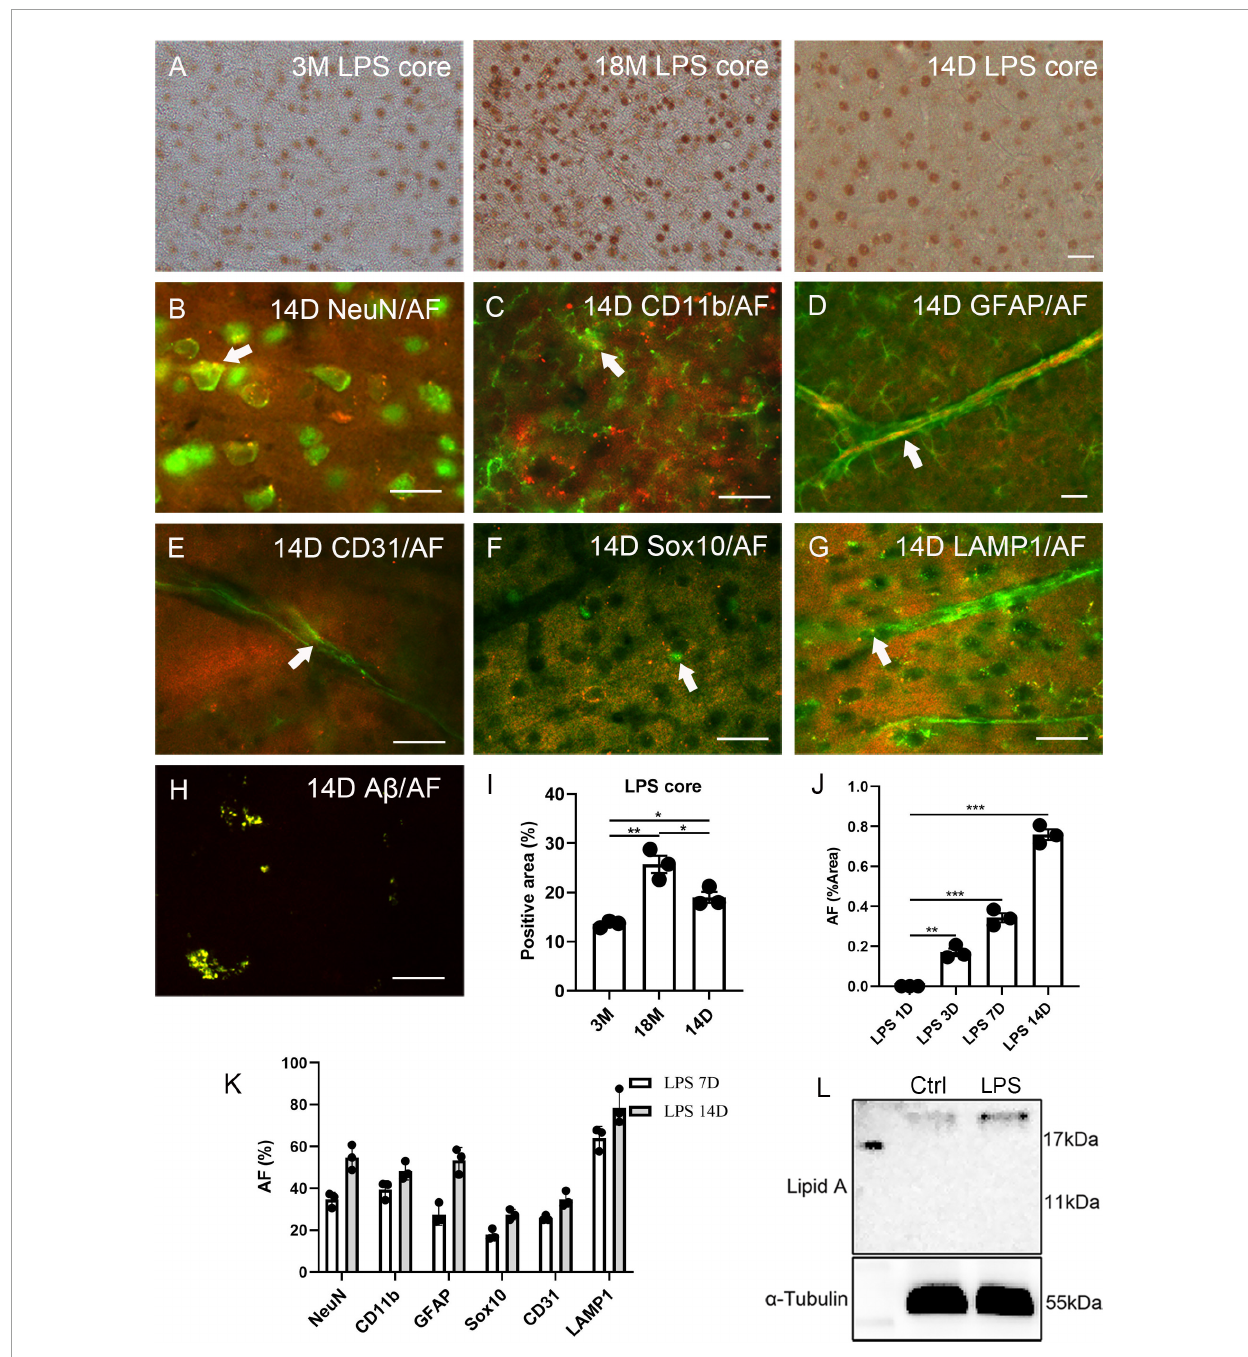
FIGURE3 Correlation between lipopolysaccharide (LPS) and AF within mouse brains. The representative images of LPS core staining of mouse brains at 3 months (3M) and 18 months (18M) of age and 14 days (14D) after LPS injection (A) . LPS-induced AF (rhodamine channel) co-localized with NeuN (B) , CD11b (C) , GFAP (D) , CD31 (E) , Sox10 (F) , and LAMP1 (G) . LPS-induced A β co-localized with AF (rhodamine channel) (H) . The positive area percentage of LPS core at 3 months (3M), 18 months (18M) of age, and 14 days after LPS injection (I) . The area percentage of AF in 1 day (1D), 3 days (3D), 7 days (7D), and 14 days (14D) LPS-injected mouse brain sections (J) . The percentage of AF-positive cells 7 days (7D) and 14 days (14D) mice after LPS injection (K) . Western blot of lipid A of the cortex of 6 weeks old mice after LPS injection for 1 day and age-matched control (L) . The arrows indicate fluorescence coincident with AF. The scale bars represent 20 µ m. The data are presented as the mean ± SE. Significance analysis with one-way analyses of variance (ANOVA) followed by Tukey’s multiple comparisons test. * p < 0.5, ** p < 0.01, *** p < 0.001.